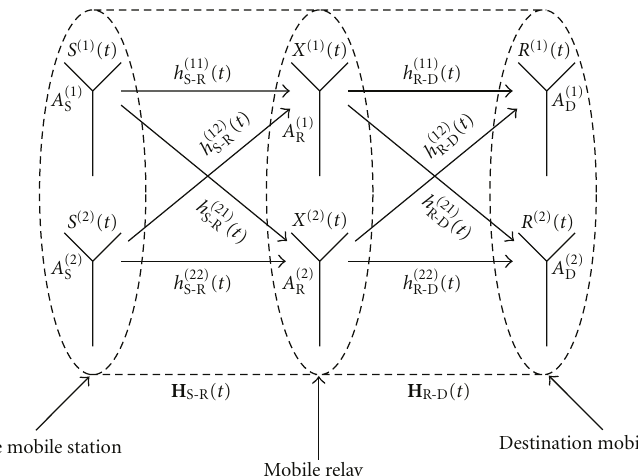
Figure 2: A simplified diagram describing the overall MIMO M2M channel from the source mobile station to the destination mobile station via the mobile